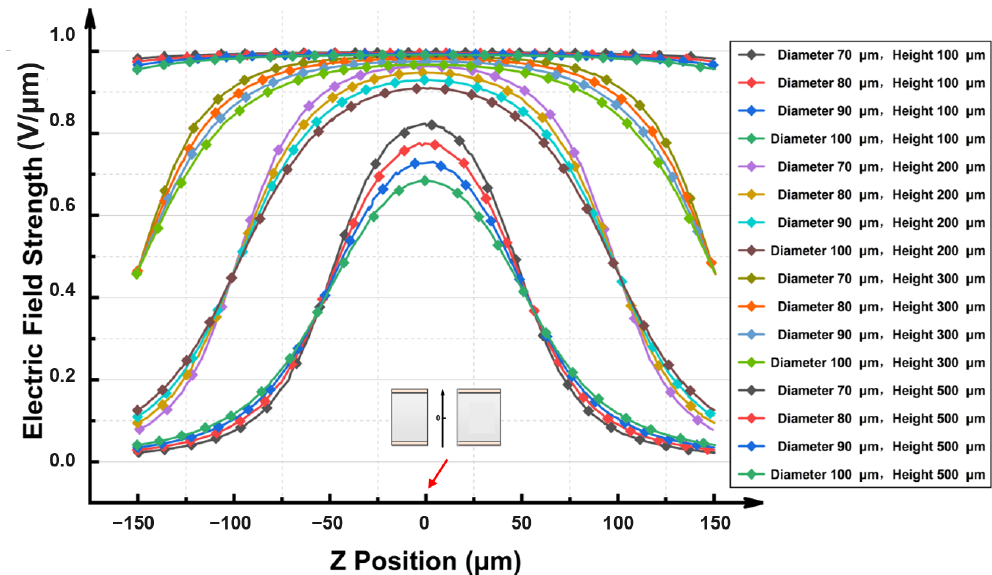
Figure 4. Field strength along the line perpendicular to the electrodes passing through the central axis of the hole.